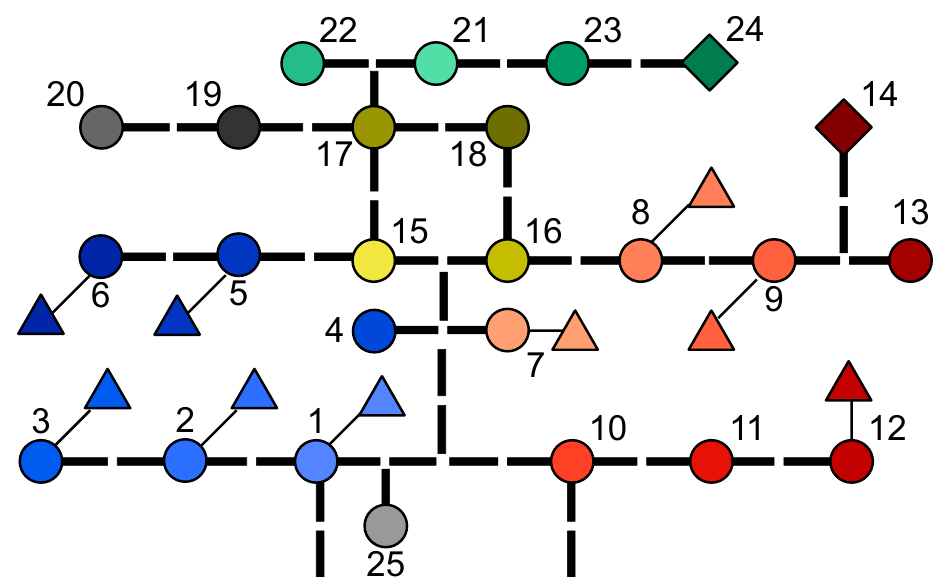
Figure 6. Colors used for each channel in the loudspeaker orchestra. The circles are the main loudspeakers and the triangle are the auxiliary loudspeakers that were used in some channels to approximate the directivity of certain instruments